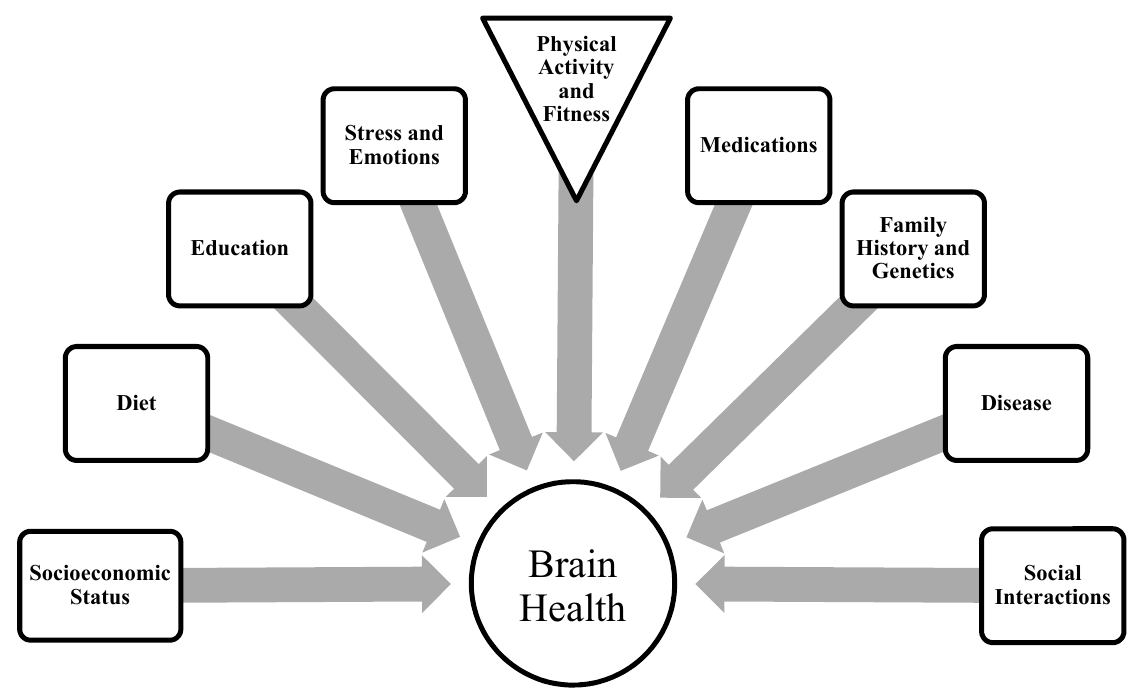
Figure 2. Schematic representing the numerous factors that modulate the relationship between brain function and physical